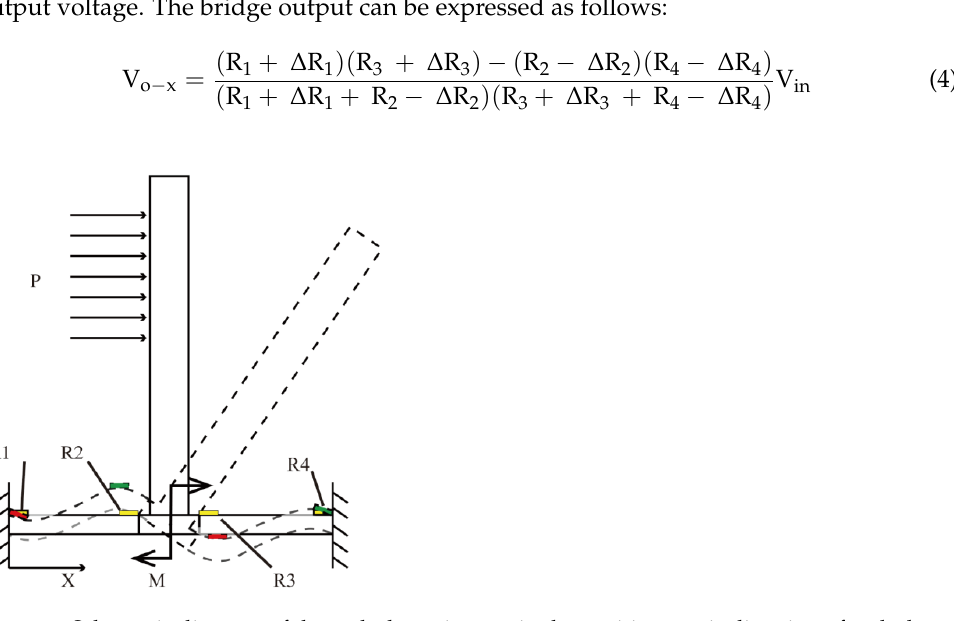
Figure 8. Schematic diagram of the turbulence impact in the positive x -axis direction of turbulence sensor.